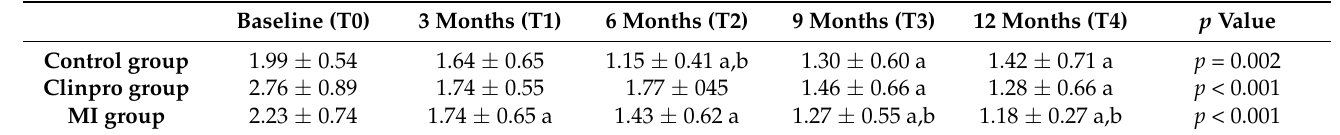
Table 4. Turesky et al. Modified Quigley Hein Plaque Index evolution during the five check-ups. Baseline